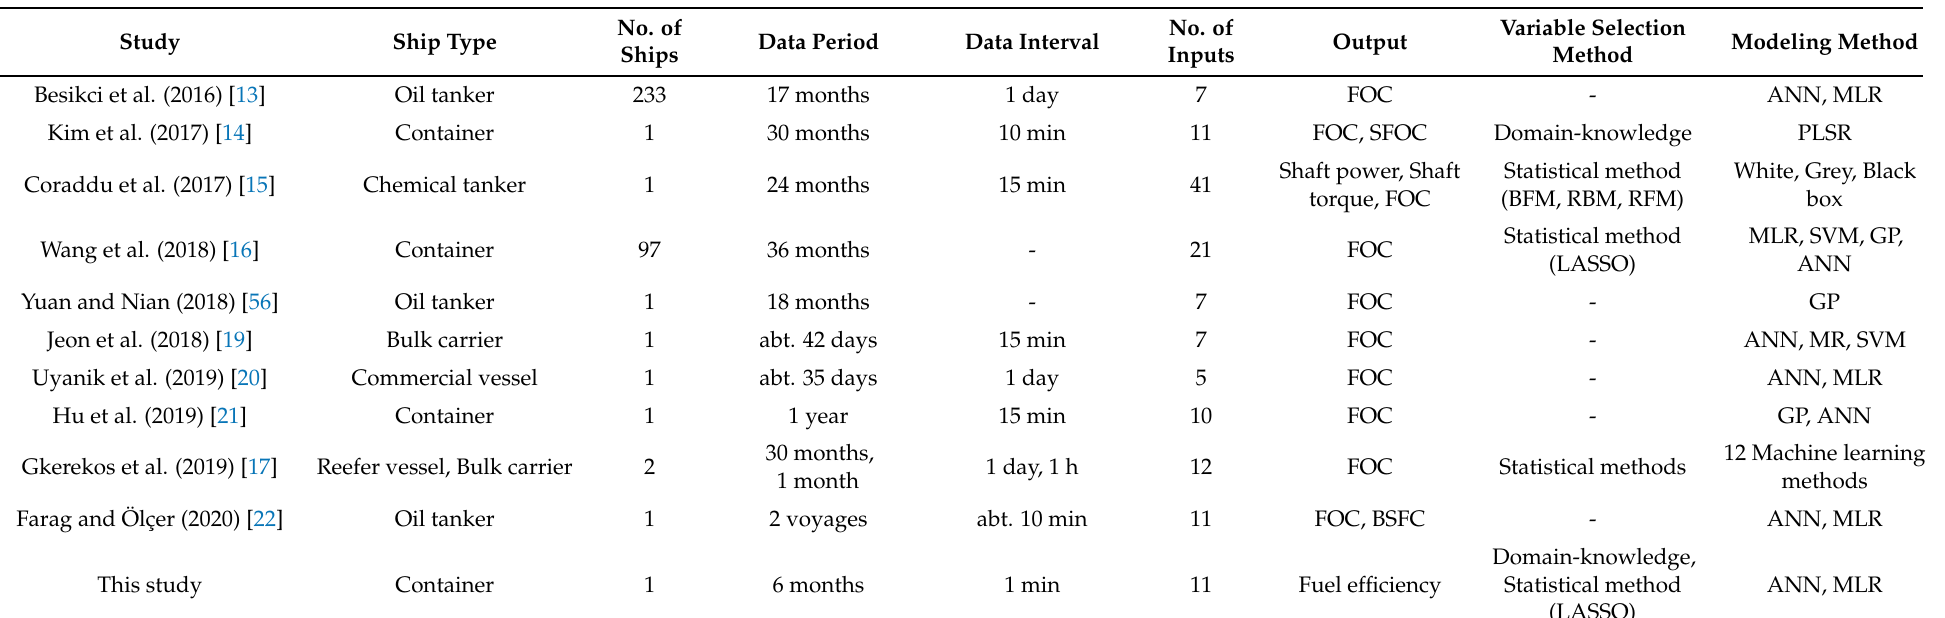
Table A1. Comparison of previous works with this